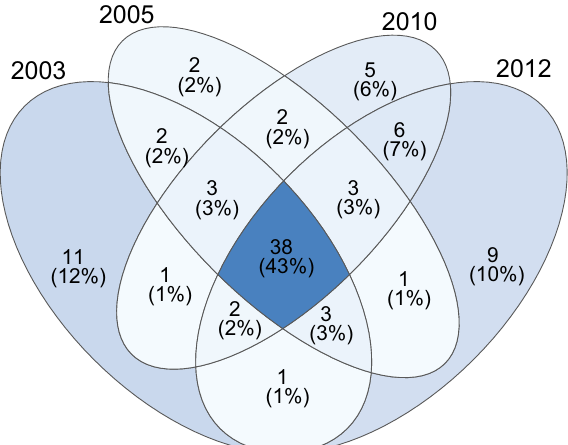
Figure 3. Venn diagram showing the species number occurring in individual years of the sampling and the species numbers, which were found in different years.